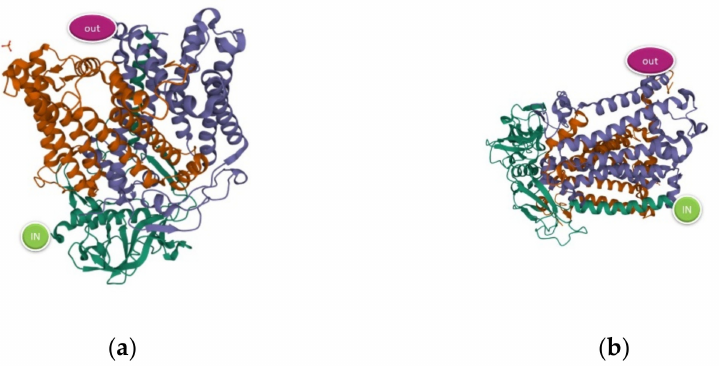
Figure 1. Cartoon of b RC with different positions of the electrical contacts. On the left, ( a ) the up-down configuration with the “IN” contact on the cytoplasmic side and the “out” contact on the periplasmic side. On the right, ( b ), the transverse configuration, with both contacts on the periplasmic side. In both cases, the “IN” contact is on the H chain, but on different